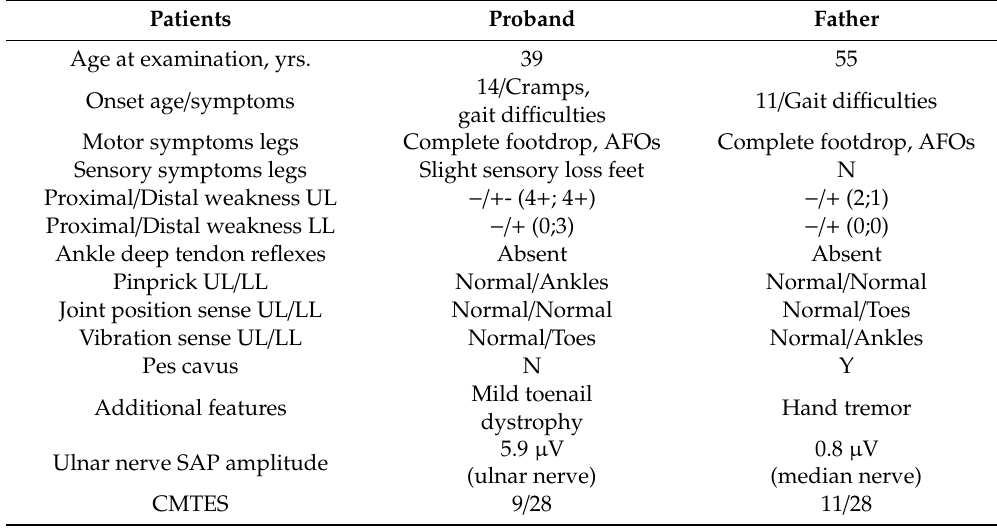
Table 2. Clinical features of